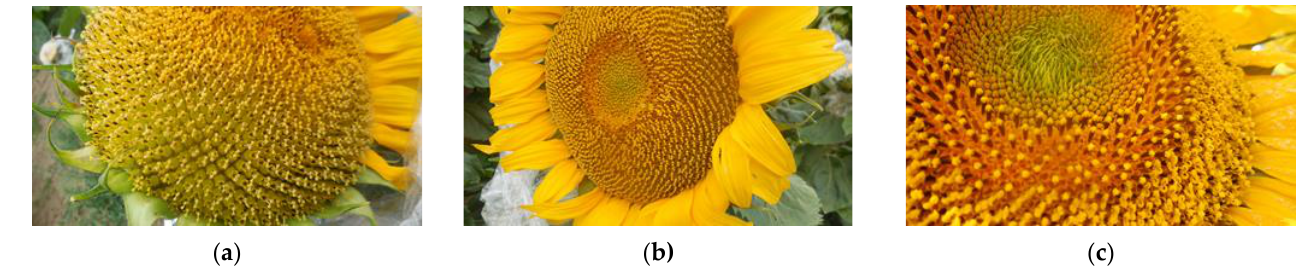
Figure 8. Phenotypic evaluation of the partially male sterile EMS-treated F1 plants Mut 1 ( a ) und Mut 10 ( b ) in comparison to the male fertile, untreated F1 hybrid cmsHA342 x RHA325 ( c ).